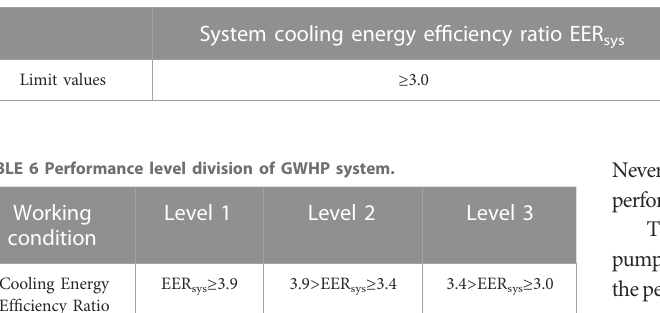
TABLE 5 Limits of performance coef fi cient of GWHP.